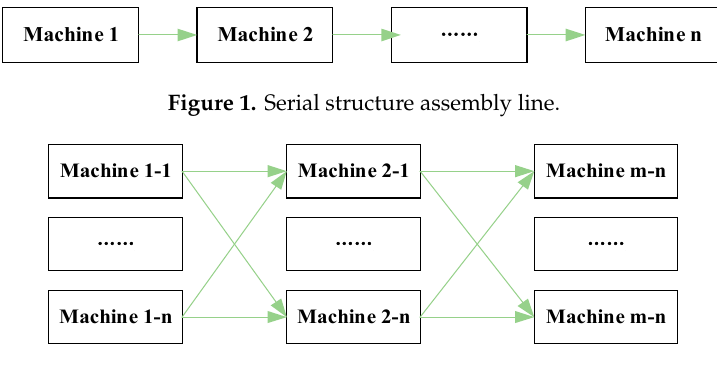
Figure 2. Parallel structure assembly line.